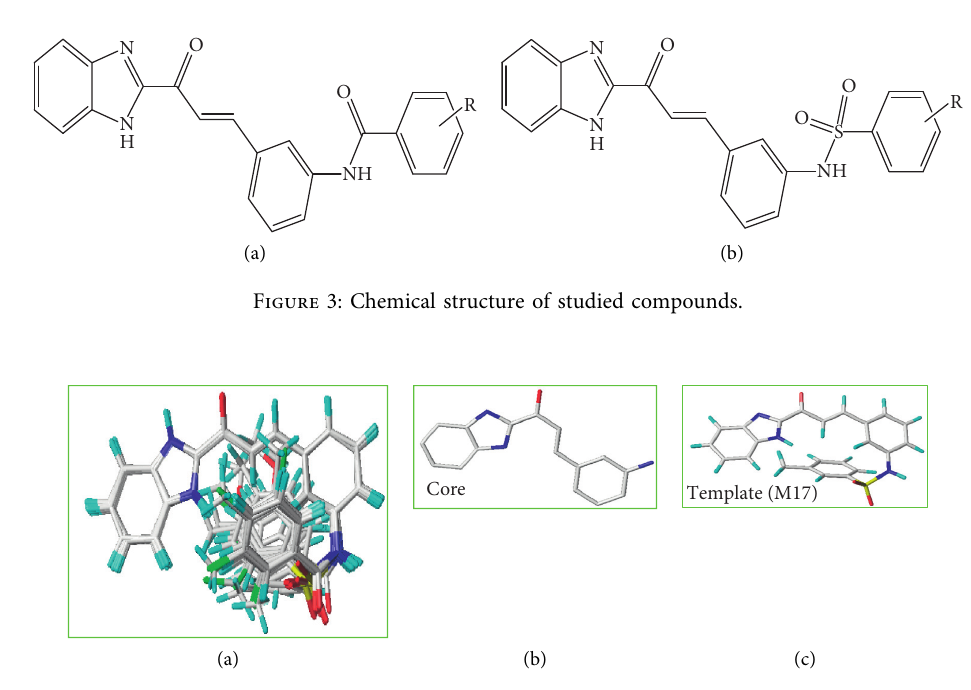
Figure 4: 3D-QSAR structure superposition of the core and alignment of the training set using molecule 17 as a